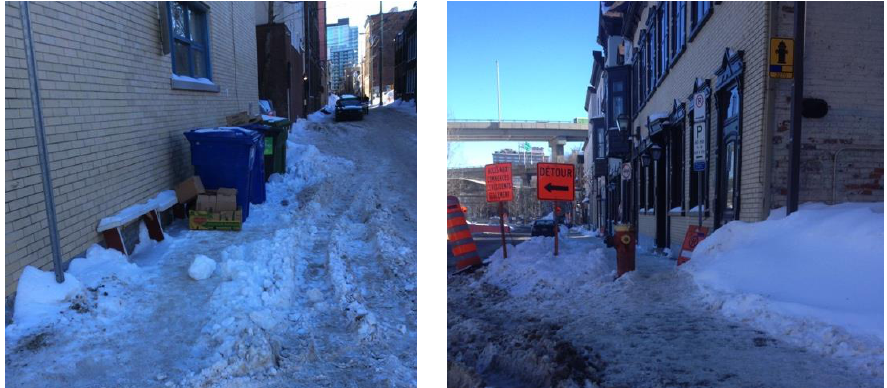
Figure 4. Examples of barriers on the sidewalk.